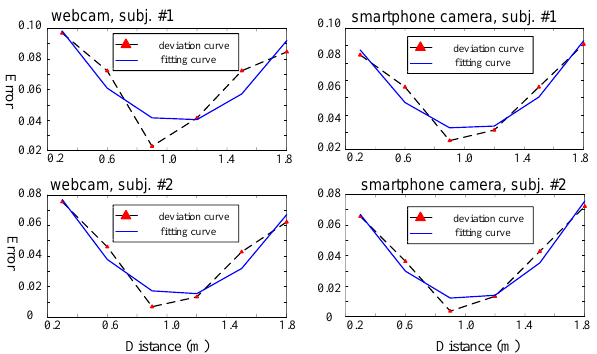
Fig 5. PPGi heart rate measurement error vs. face-camera distance Table 3. Best measurement for each subject and each camera